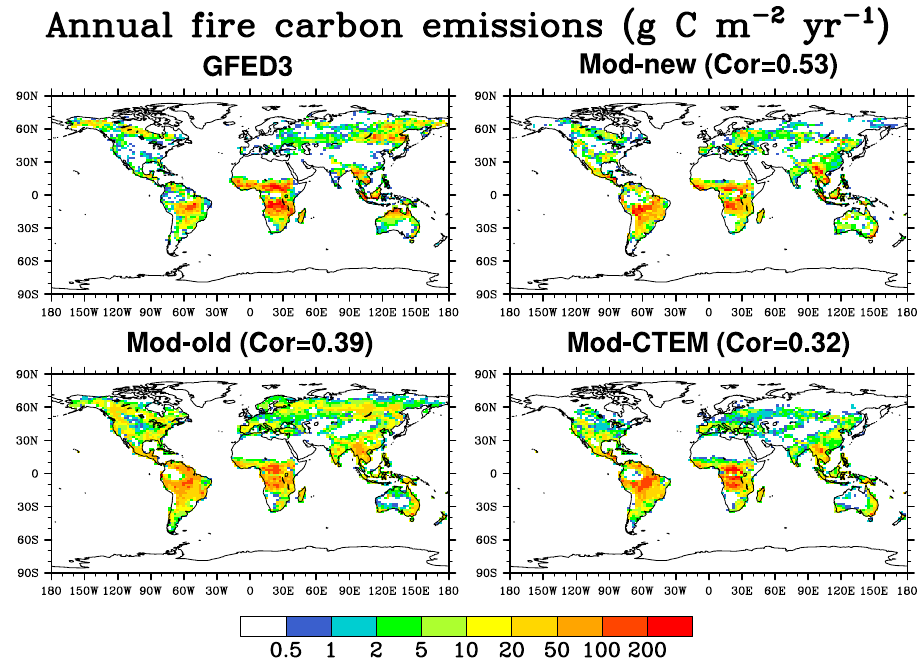
Fig. 16. Same as Fig. 9, but for annual fire carbon emissions.